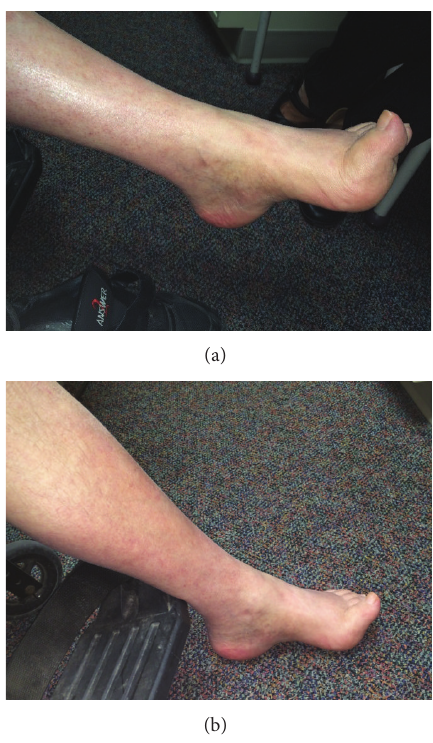
Figure 1: Evidence of pes cavus and hammer toes in our